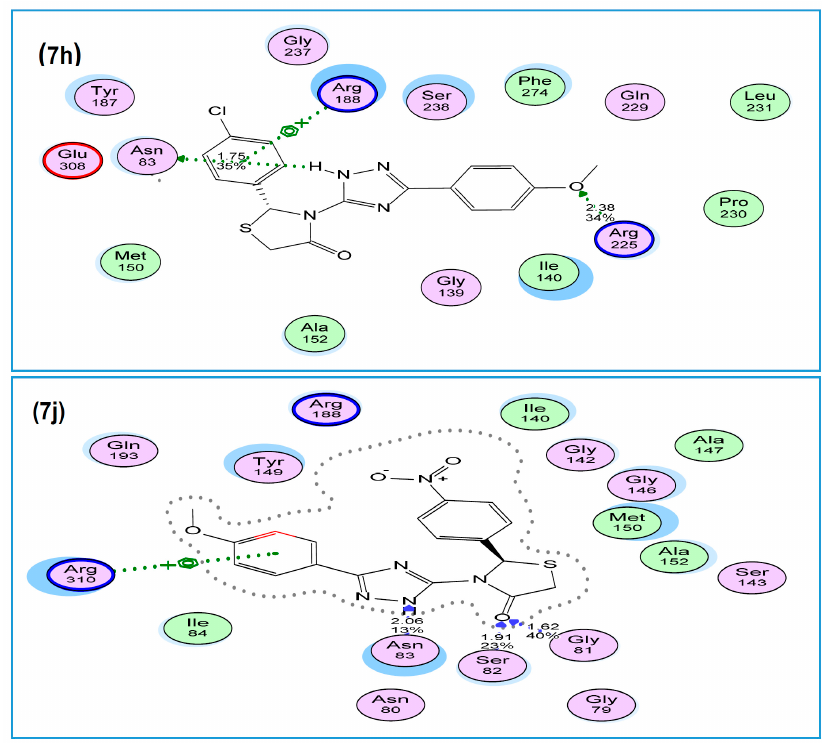
Figure 4. 2D binding mode interaction and residues involved in the recognition of the most promising Compounds 7h and 7j into MurB binding site interaction showing the percentage of hydrogen bonds.